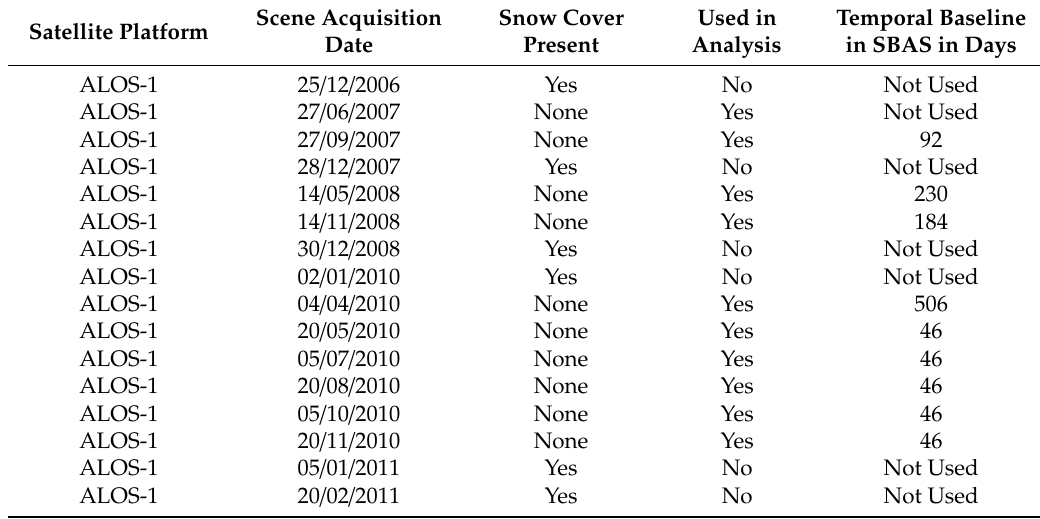
Table 1. ALOS-1 Scene characteristics and suitability (orbit 194, frame 770, Fine Beam Mode).